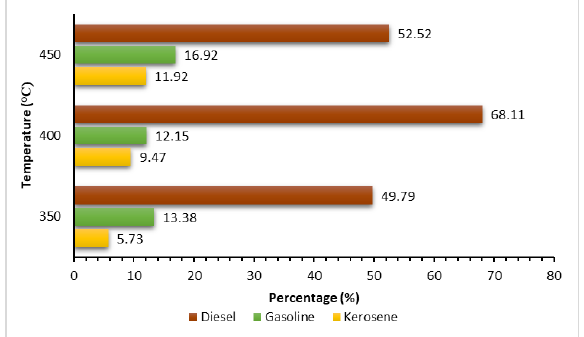
Fig. 6. Pyro-oil a) before and b) after second fractional distillation process.